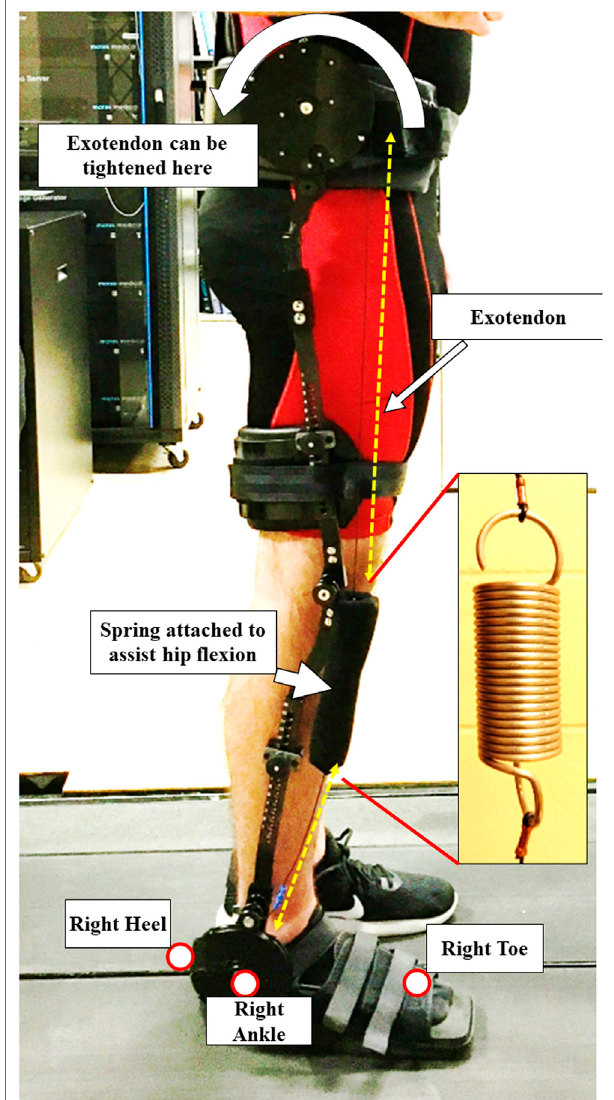
FIGURE 2 | A participant with the passive exoskeleton attached to their right dominant leg. The spring is attached to a cable called the Exotendon, whichcanbetightenedbythediskonthewaist.Whileapersonisinthestance phase of gait, the spring is extended, storing energy. When a person propels forward, the spring provides assistance by returning the energy. The fi gurealsoshowsthepositionsoftheretro-re fl ectivemarkersthatwereusedin the